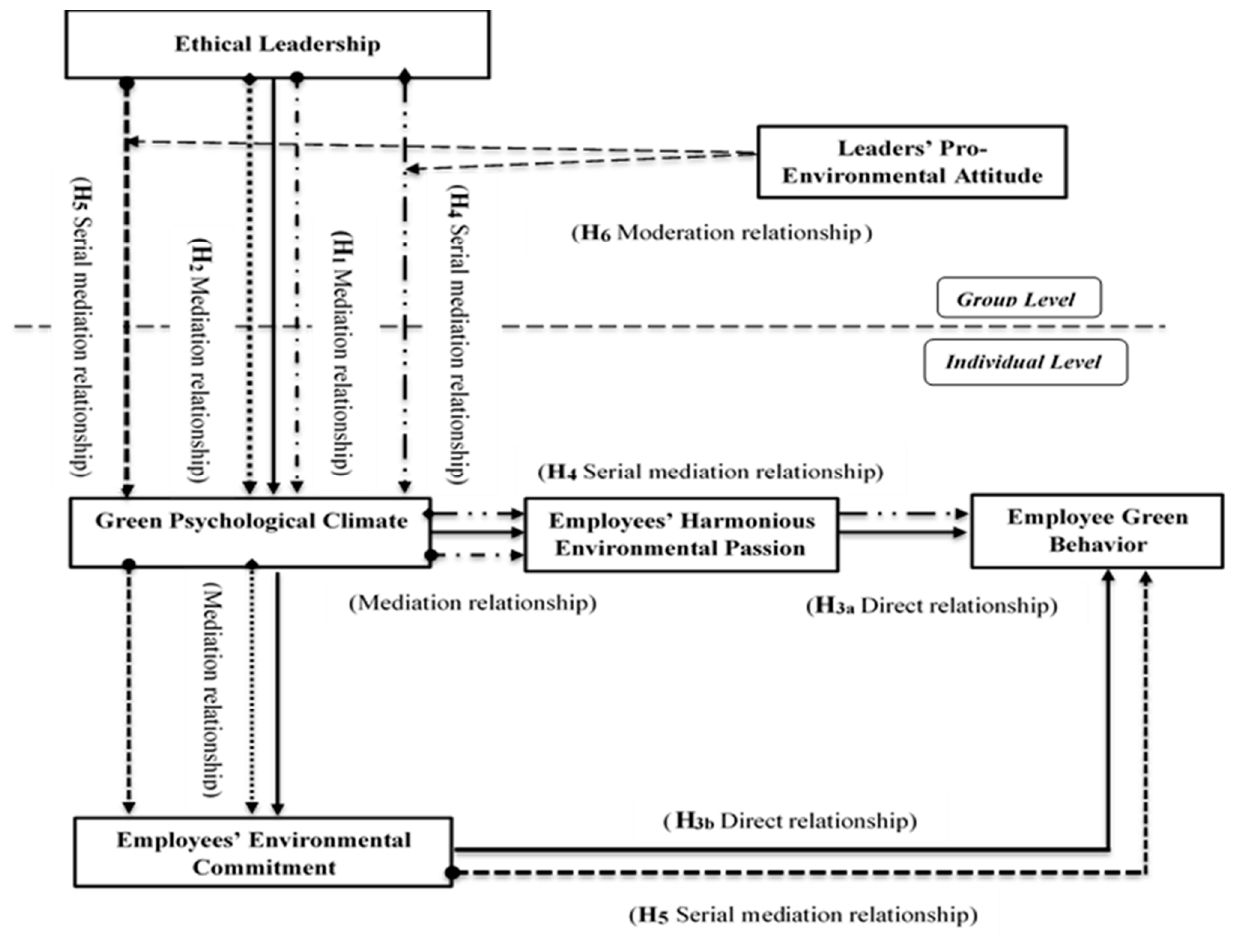
Figure 1. Hypothesized Model.